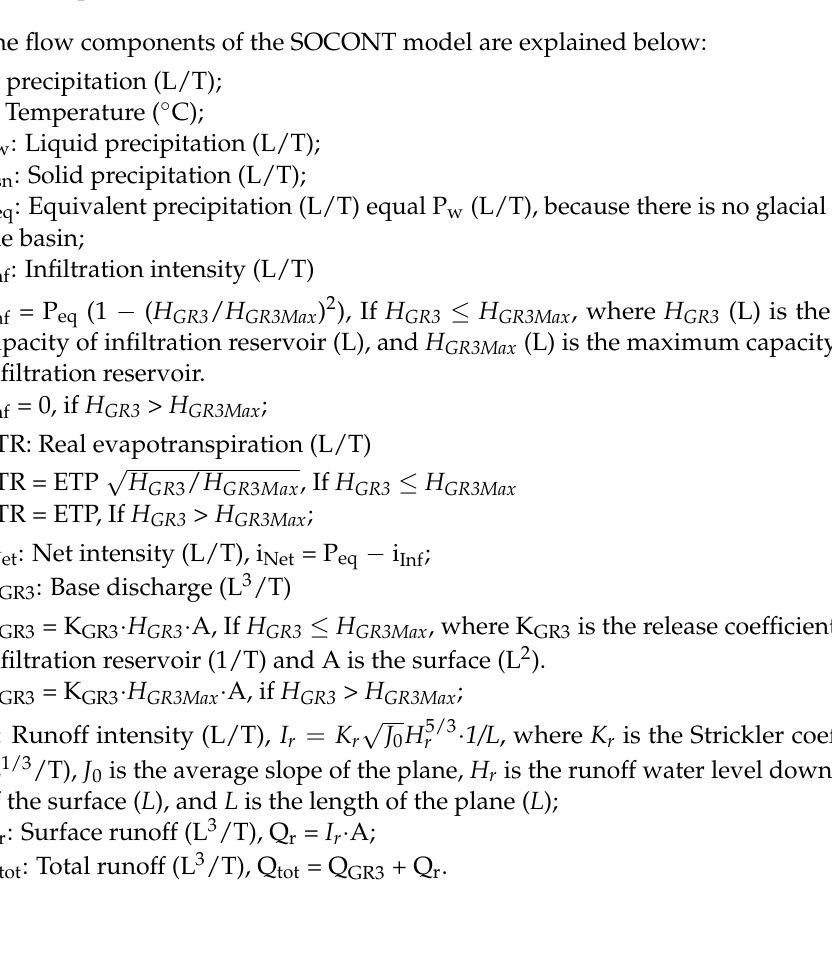
Figure 11. Composition of the SOCONT